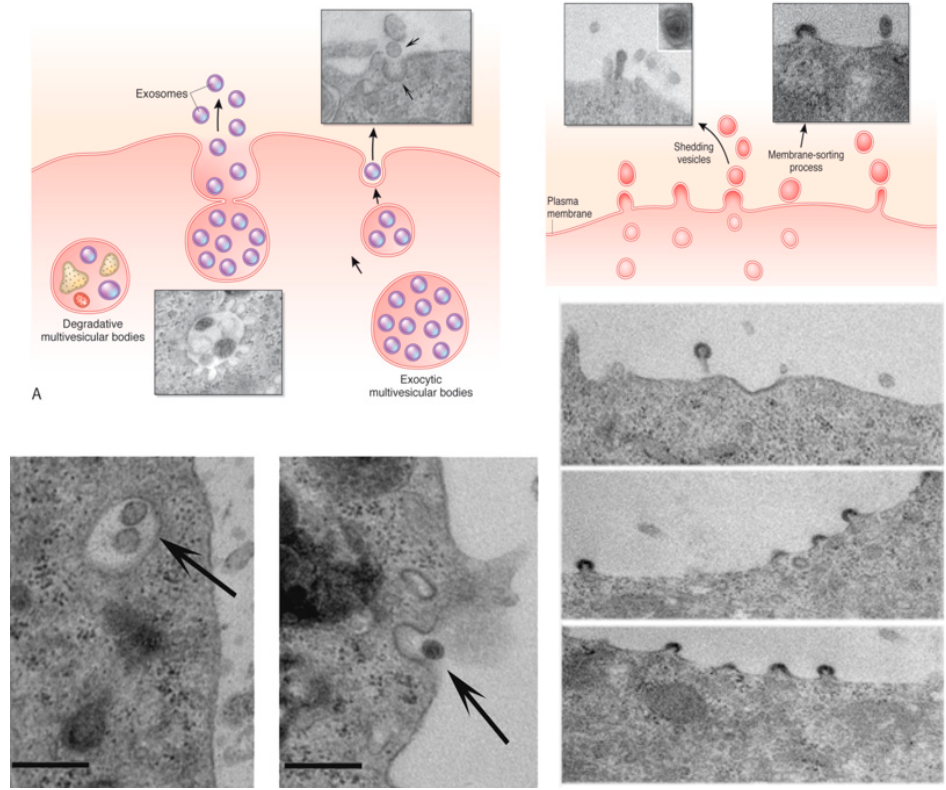
Figure 4. EVs from stem /progenitor cells as a paracrine/endocrine mechanism.